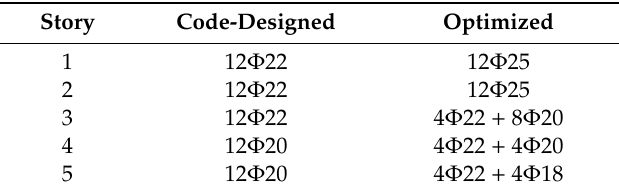
Figure 7. Longitudinal reinforcement of single column for each floor comparisons of CSDBC-designed structure and optimized structure. Table 3. Longitudinal reinforcement of columns for code-designed and optimized structures .